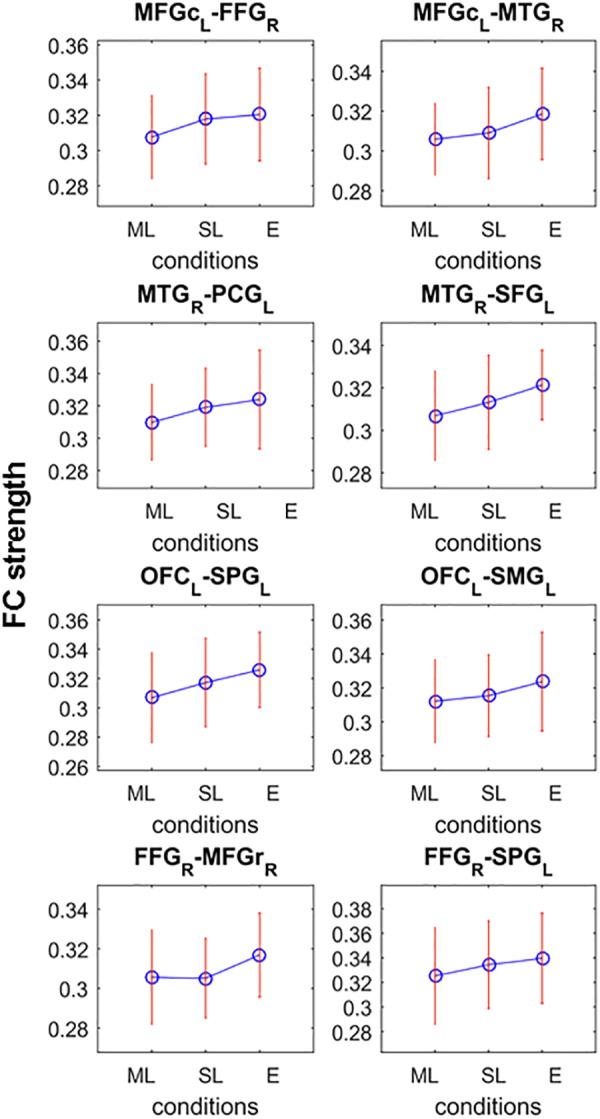
Significant network of the post-hoc analysis testing monotonic FC strength behavior as a function of loudness difference. Connections possess significant difference between at least two loudness level which the criteria that the FC strength (shown on y-axes) monotonically increase (ML, moderately louder distractor; SL, slightly louder distractor; E, equal loudness) for all but the last two nodes (FFG-MFGr and FFG-SPG).